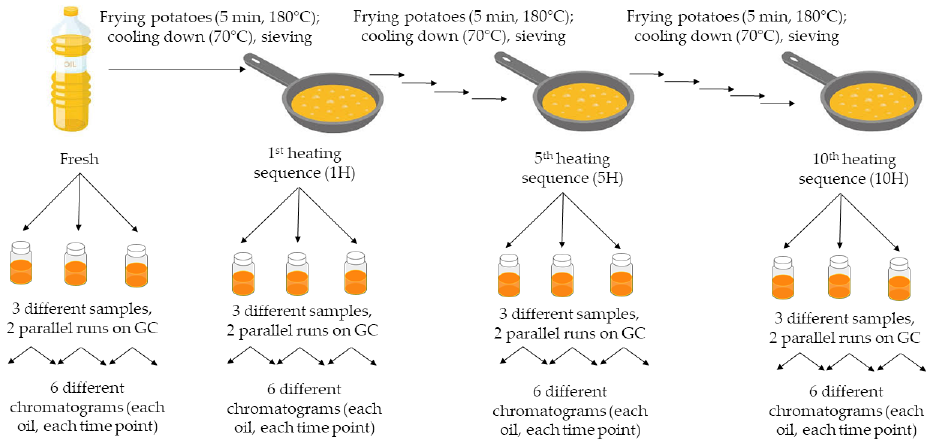
Figure 1. Flow diagram of the frying protocol and sample collection.